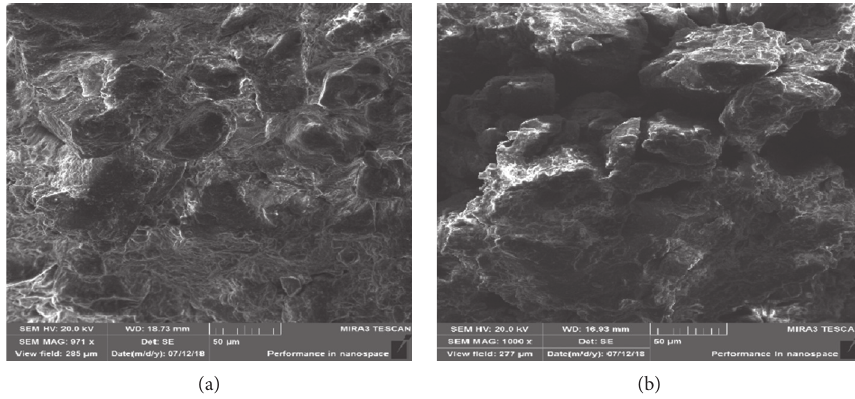
Figure 11: SEM images of silt sand before and after freeze-thaw.